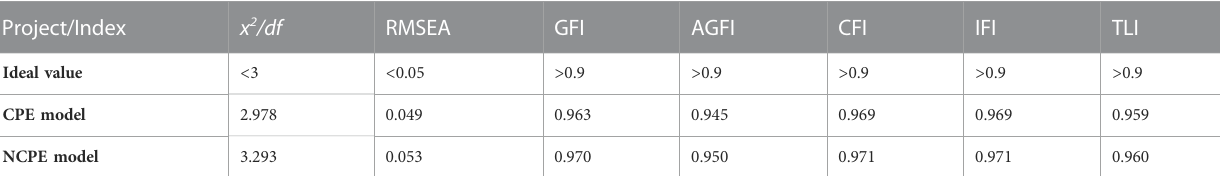
TABLE 3 Integral fi tting coef fi cient.